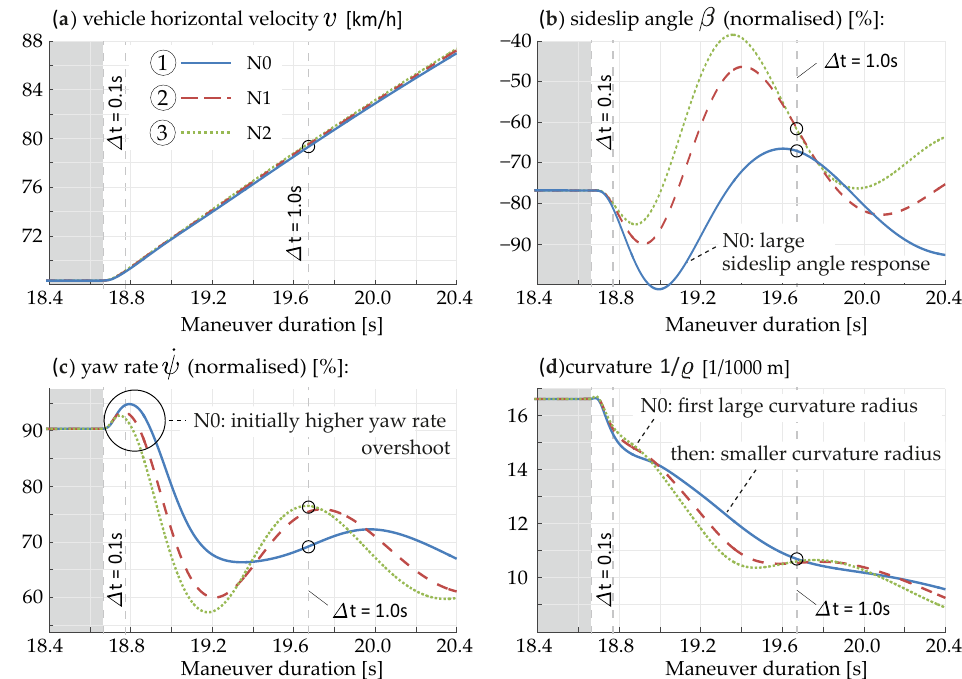
Figure 15. Vehicle motion during “Power On Cornering“ maneuver ( R = 60m , a y 0 = 6m/s 2 ) on wet road ( µ max = 0.6): ( a ) vehicle velocity; ( b ) sideslip angle; ( c ) yaw rate; ( d ) curvature of the